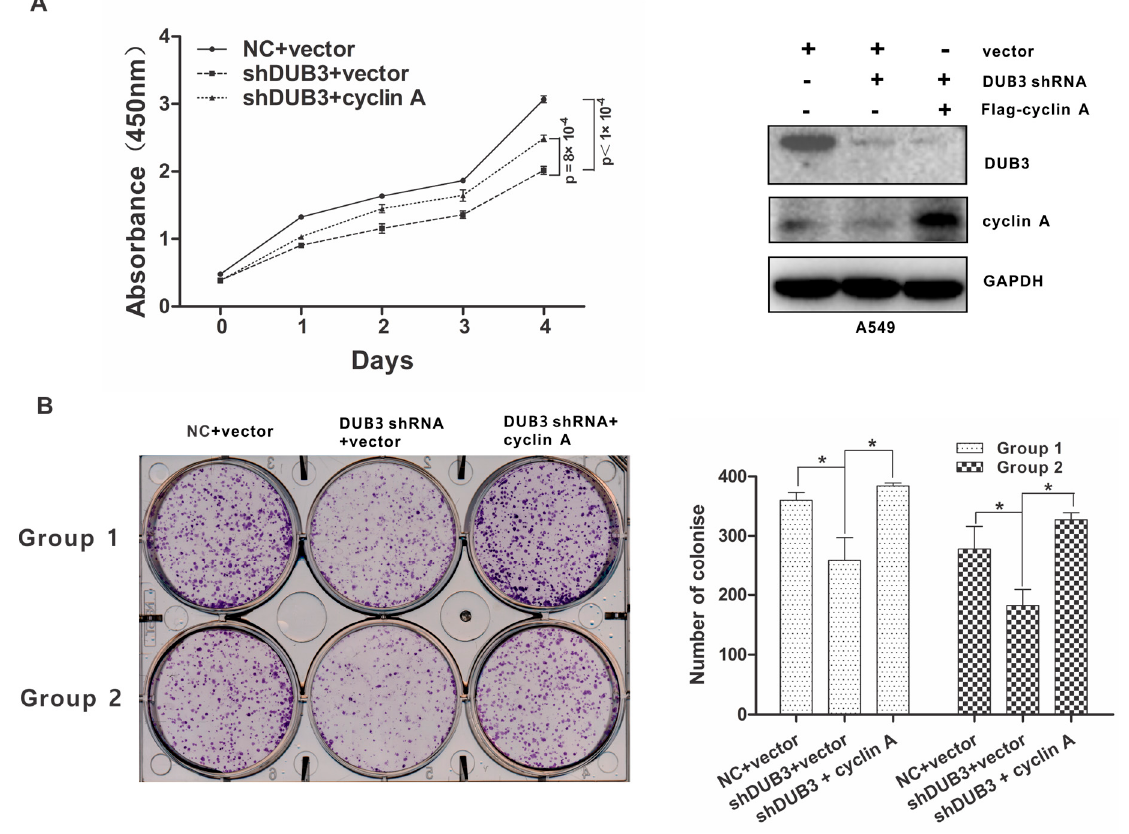
Figure 6. DUB3 promotes NSCLC cell proliferation via cyclin A. ( A , B ) A549 cells were infected with the indicated lentiviral shRNAs and then transfected with the indicated constructs. Cell proliferation was monitored using CCK-8 assays at the indicated time points ( A ). Colony formation assay was performed ( B ). Colonies were visualized by light microscopy and quantified. Cell seeding density was 7000 cells per well (Group 1) and 5000 cells per well (Group 2), respectively. Statistical significance was determined by a two-tailed, unpaired Student’s t test. Data represent the mean ( ± S.D.) of three independent experiments (* p < 0.05).